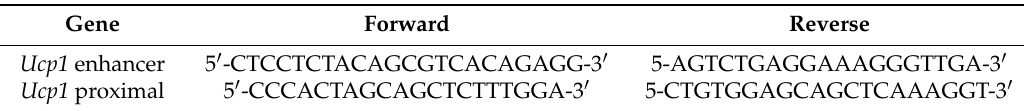
Table 2. Primers Used in Chromatin Immunoprecipitation (ChIP) Assay. Gene